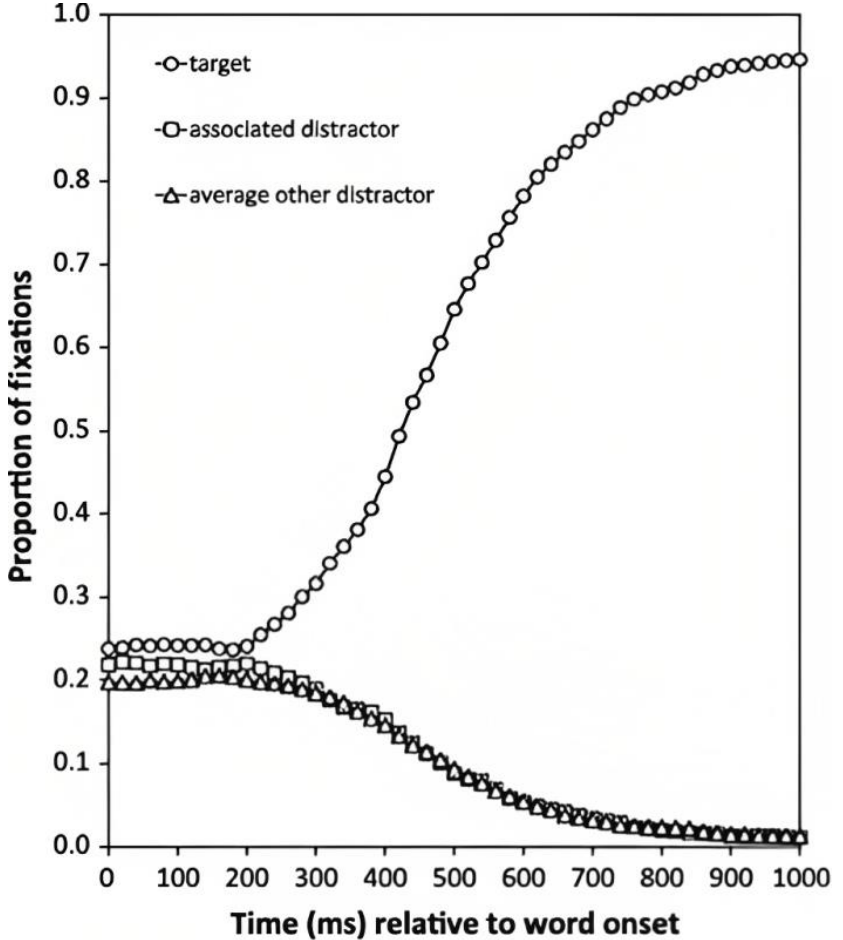
Figure 9. Proportion of fixations to the target, the associated distractor, and the averaged other distractors reprinted with permission from [76]. Copyright 2017 John Wiley and Sons. In this experiment, the participant saw a display with a target picture and three distractors and followed a simple spoken instruction to click on the target.